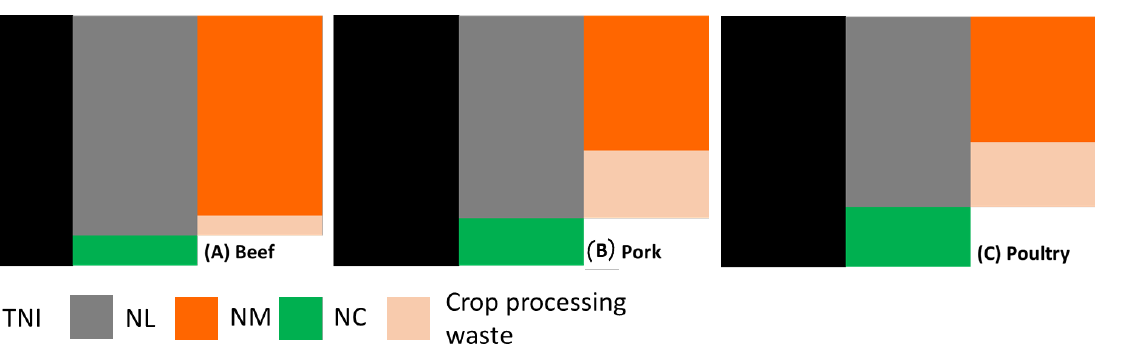
Figure 1. ( A ) Relationship between VNF and NL and ( B ) the corresponding relationship between NL and TNI per kg meat production in different countries. VNF values are given in Table S1.